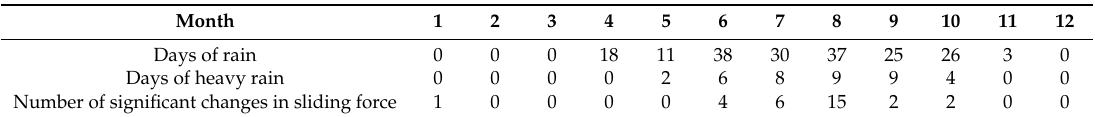
Figure 2. Frequencies of significant changes in sliding force, rain, and heavy rain during two years.